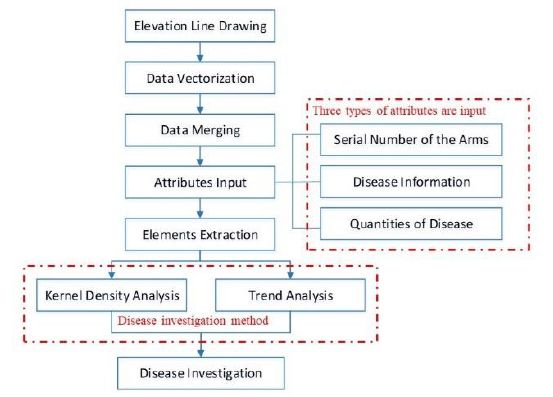
Figure 3 . Research process of the disease